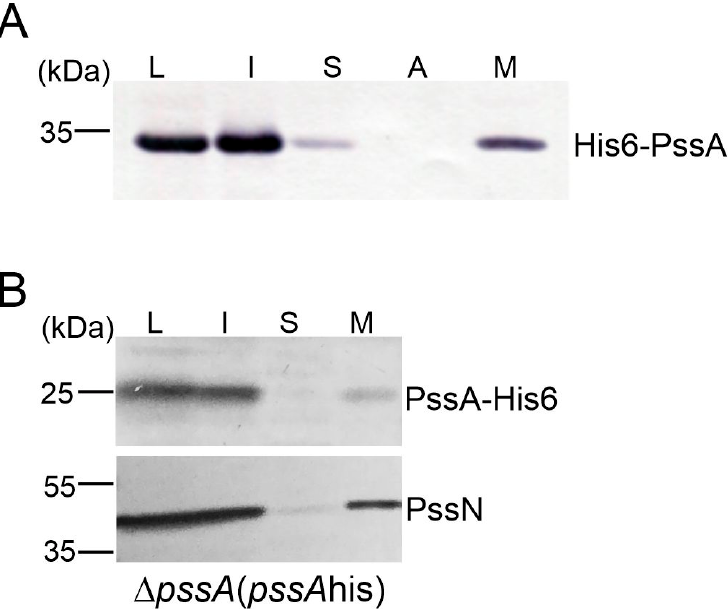
Figure 3. Study of the subcellular localization of PssA. Proteins from cell fractions obtained from E. coli BL21(DE3) carrying expression construct pET30-pssA ( A ) and ∆ pssA strain carrying pssA cloned into pBBR1MCS-2 [ ∆ pssA ( pssA his)] ( B ) were separated in SDS-PAGE and subjected to Western blotting with the anti-His 6 (for localization of tested proteins), and anti-PssN (for verification of the effectiveness of the Rhizobium cells fractionation) antibodies. The experiment was repeated twice giving the same result. L—cell lysate, I, S, M—insoluble, soluble and membrane fraction of proteins, A—fraction of membrane-associated proteins (released after NaCl washing).